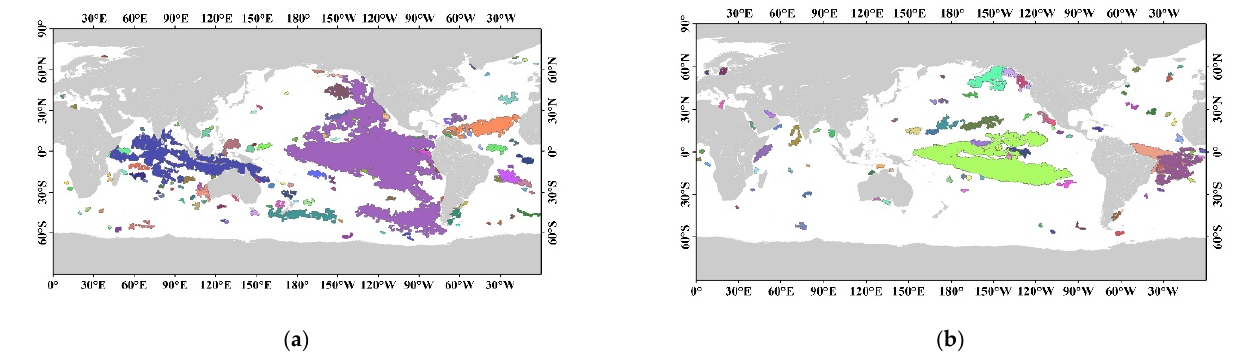
Figure 11. Spatial coverage of the process objects of SSTA. Different colors denote different process objects. ( a , b ) are warm process objects and cold process objects, respectively.